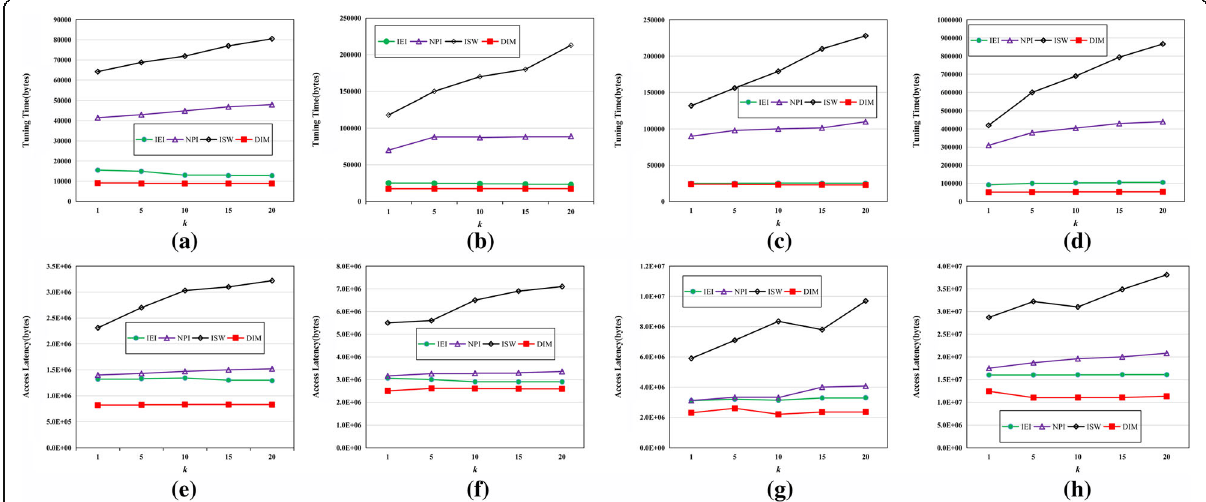
Fig. 7 Tuning time and access latency of four index approaches for kNN queries versus k . a Tuning time (OL). b Tuning time (SR). c Tuning time (CAL). d Tuning time (FL). e Access latency (OL). f Access latency (SR). g Access latency (CAL). h Access latency (FL). a – d The tuning time of four index methods on the four urban road network datasets of the OL, SR, CAL, and FLs in the case that the number of targets k to be queried is different. It can be seen from the figure that the tuning time increases linearly with the increase of the k value for the ISW index, especially on the FL large-scale data set; the tuning time of k = 20 is more than two times that of k = 1, which is related to the long broadcast period of